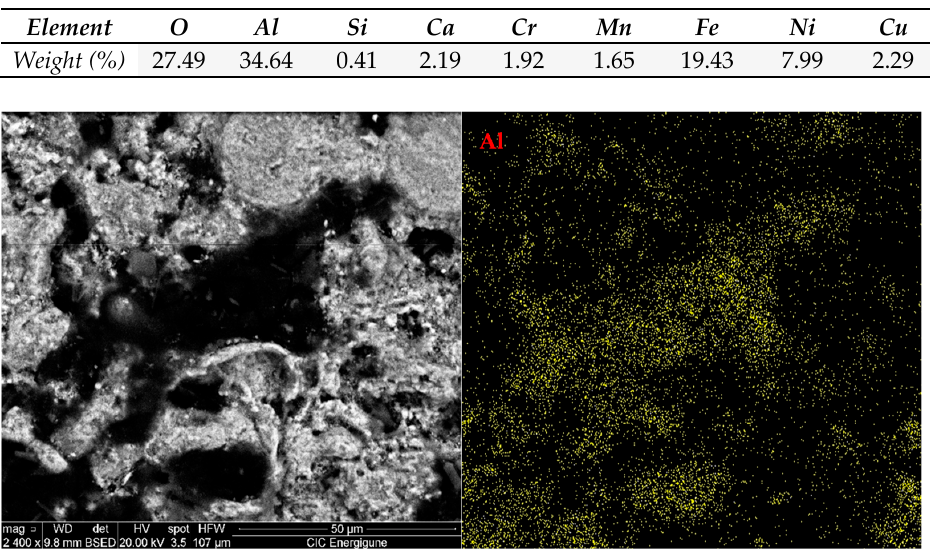
Figure 8. Superficial image magnification of OC4 alloy after 500 h in LiOH at 470 °C and mapping analysis (Al).